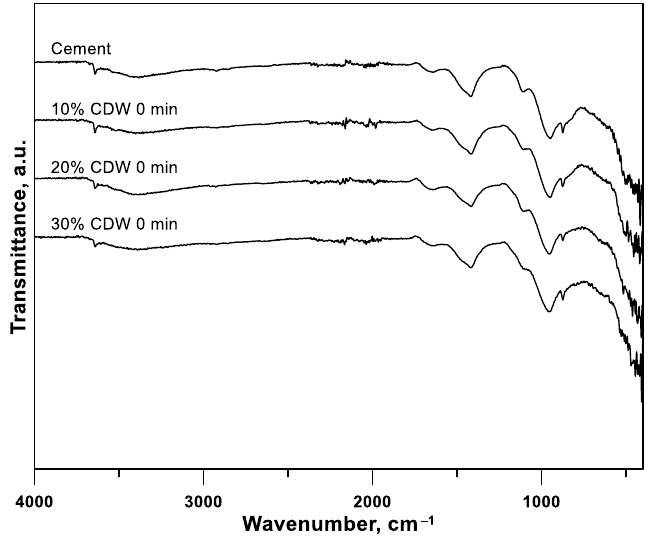
Figure 4. FTIR spectra of samples with different CDW content.